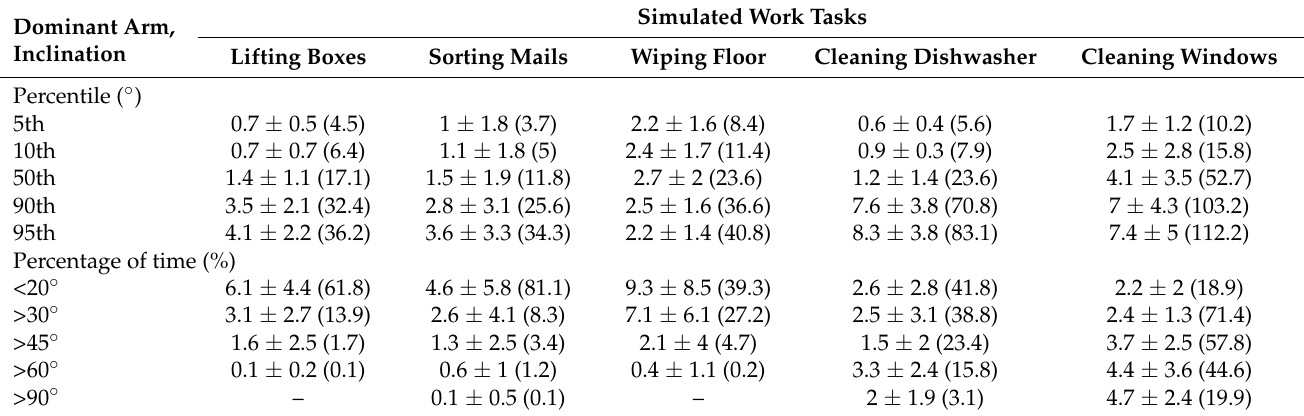
Table 1. The mean and the standard deviation (mean ± SD) of the mean absolute errors (MAEs) of the dominant upper arm inclination angle between cloth sensors and skin sensors during the five simulated tasks, with the reference value of skin sensors shown in brackets ( n =